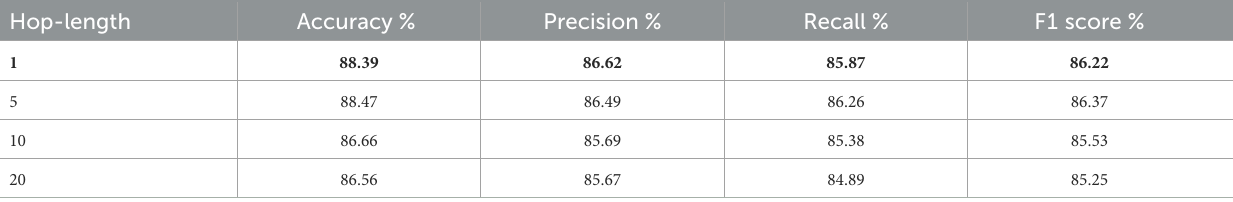
TABLE 2 Table of average performance results generated by adjusting the parameter Hop Length model in the Fourier transform. Hop-length